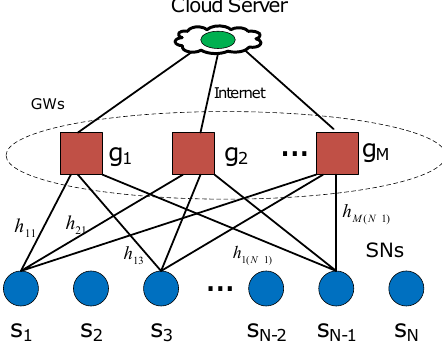
Figure 1. The network topology of the TO